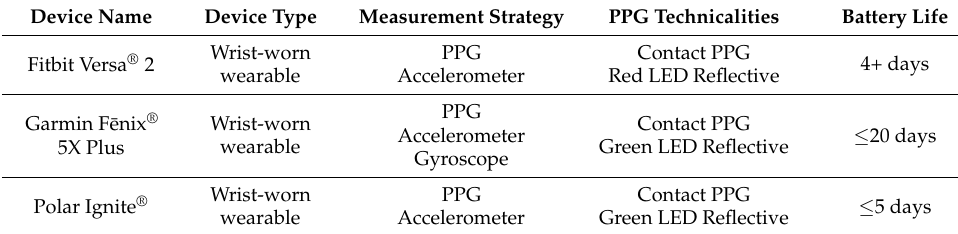
Table 1. Technical specifications of the used